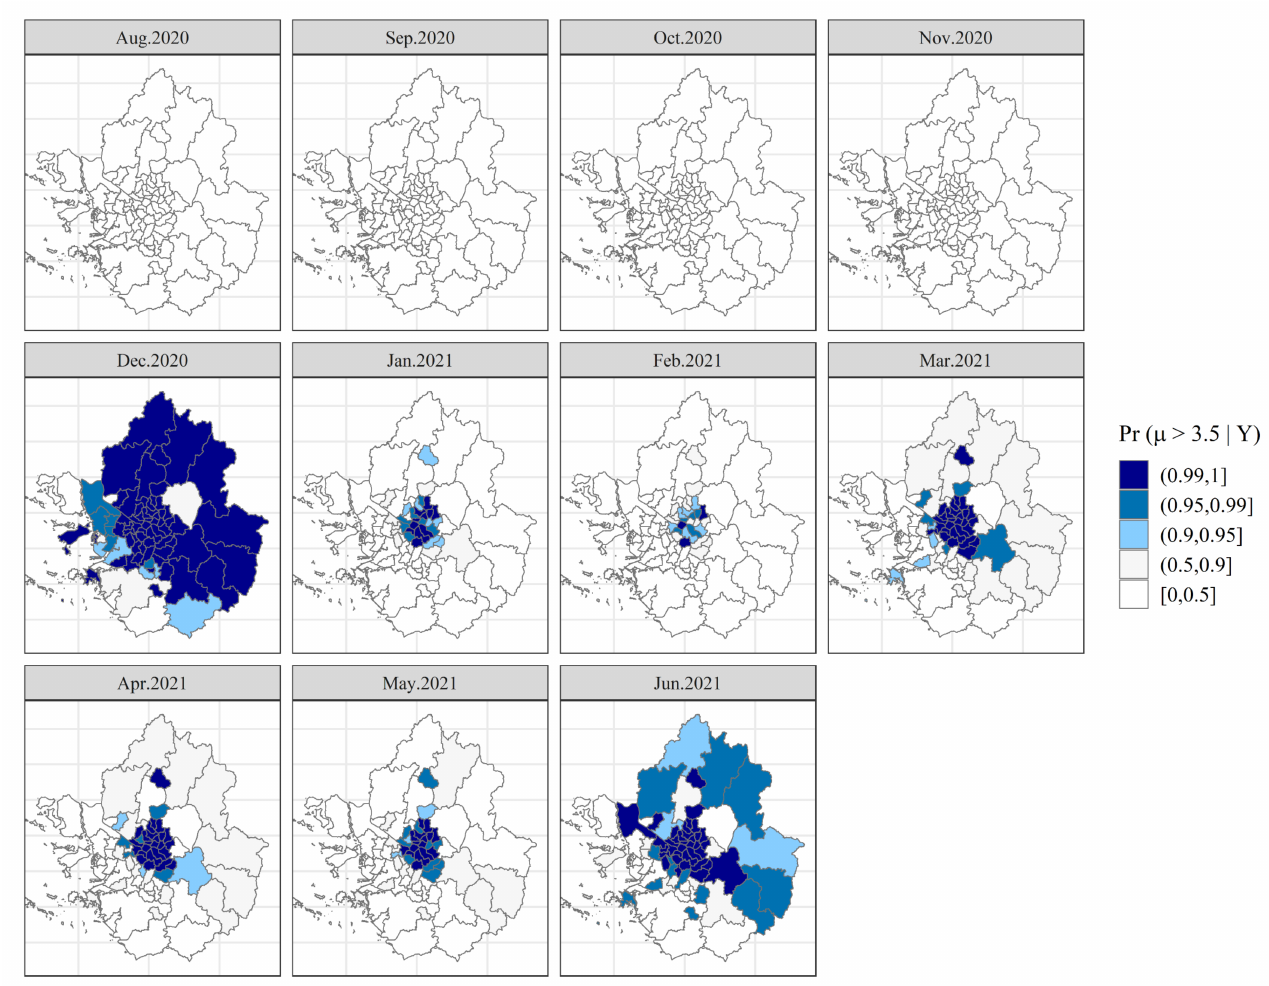
Figure 7. Exceedance probabilities of the dynamics of COVID-19 transmission